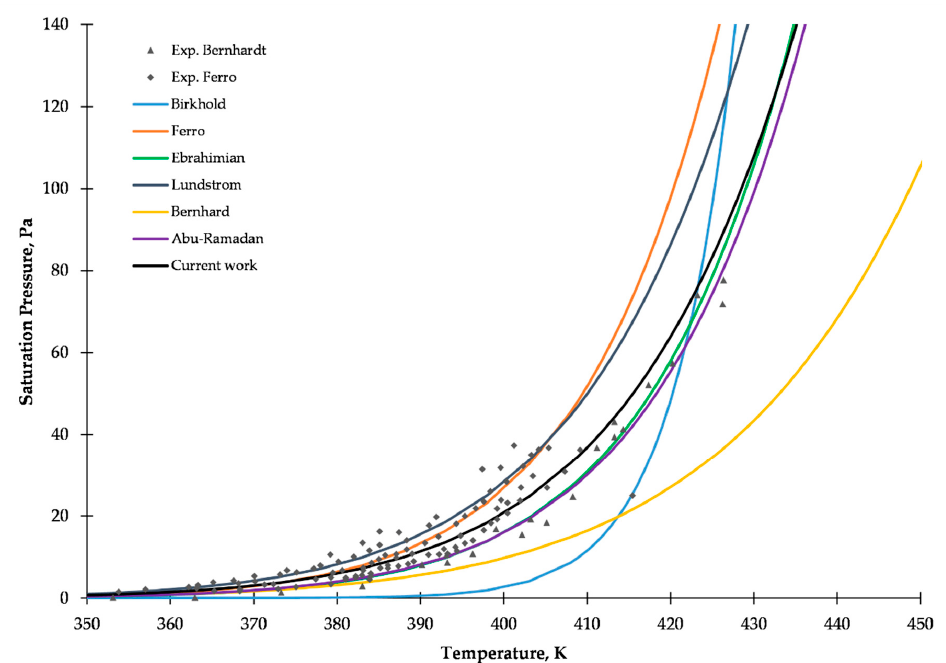
Figure 2. Comparison of saturated vapor pressure used in the references [10–15] with experimental results.